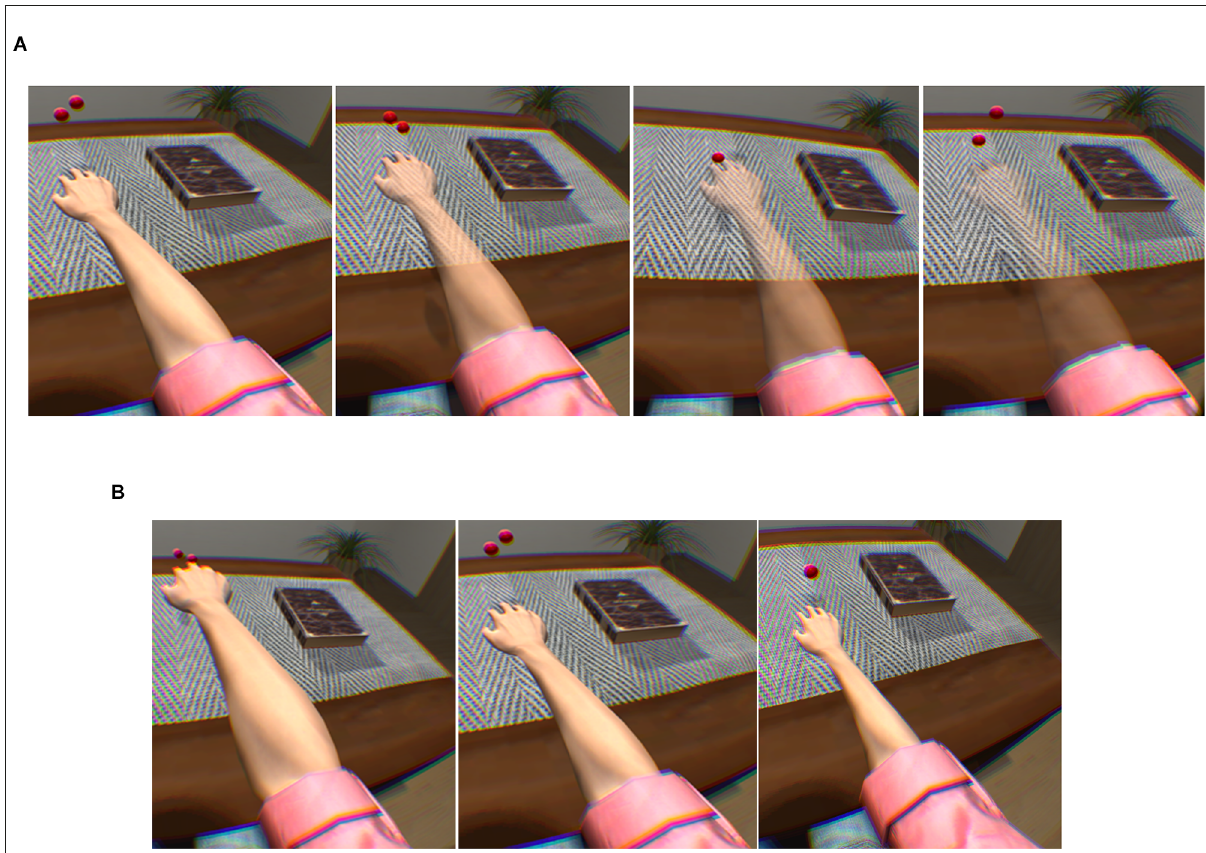
FIGURE3 Transparency and size illusions of an embodied virtual arm. (A) Virtual arm illusion showing arm at 0%, 25%, 50%, and 75% transparency. (B) Virtual arm illusion showing enlarged, normal, and reduced size arm. Note the use of bouncing red balls in which vibration feedback is provided when the balls touch the skin. This visuotactile congruence stimulation helps induce the embodiment illusion. Reprinted from Matamala-Gomez, M. et al. (2019b). Decreasing pain ratings in chronic arm pain through changing a virtual body: different strategies for different pain types. The Journal of Pain 20(6), 685–697. © 2019, with permission from